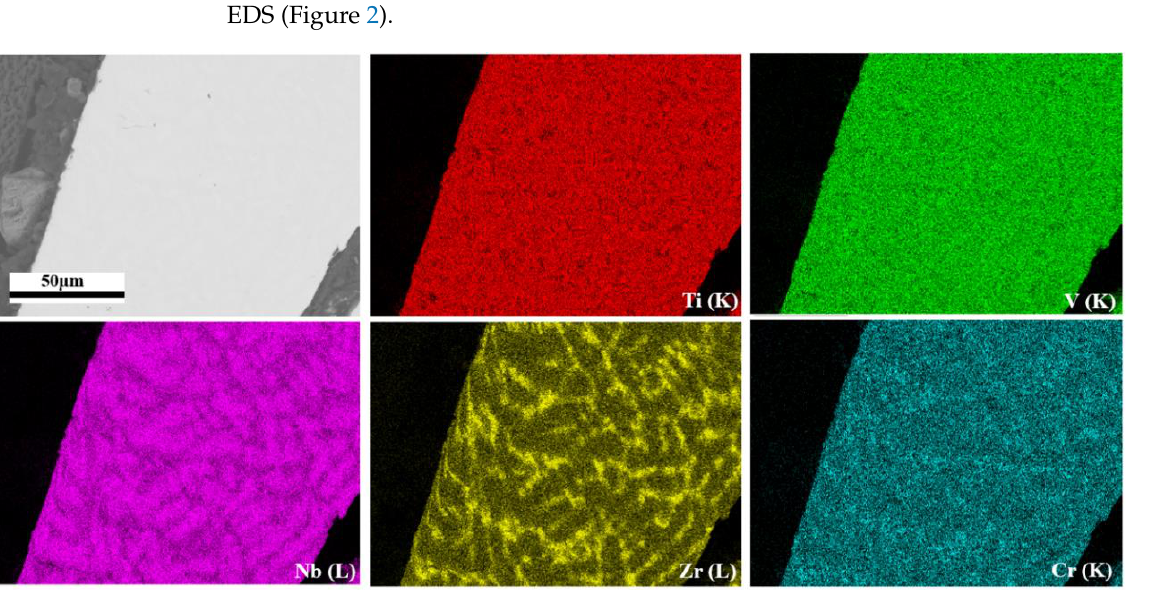
Figure 2. SEM image and related EDS chemical mapping of the as-cast Ti 0.30 V 0.25 Cr 0.10 Zr 0.10 Nb 0.25 al- loy.